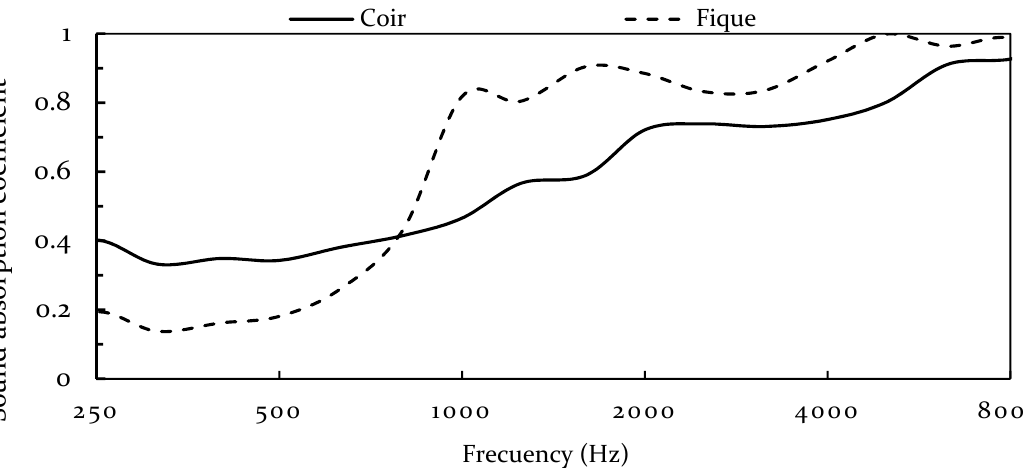
Figure 14. Coir and Fique panels measured sound absorption.